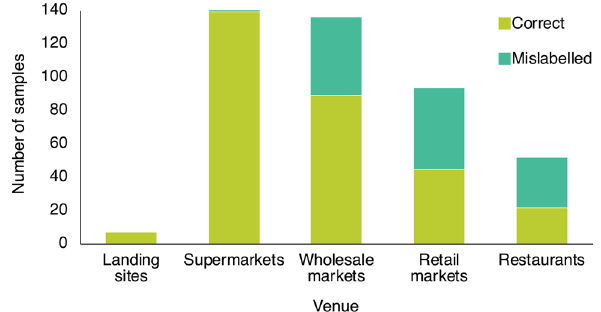
Figure 1. Number of mislabelled samples by venue (N = 449; Landing sites = 7; Supermarkets = 160; Wholesale markets = 136; Retail markets = 94; Restaurants =